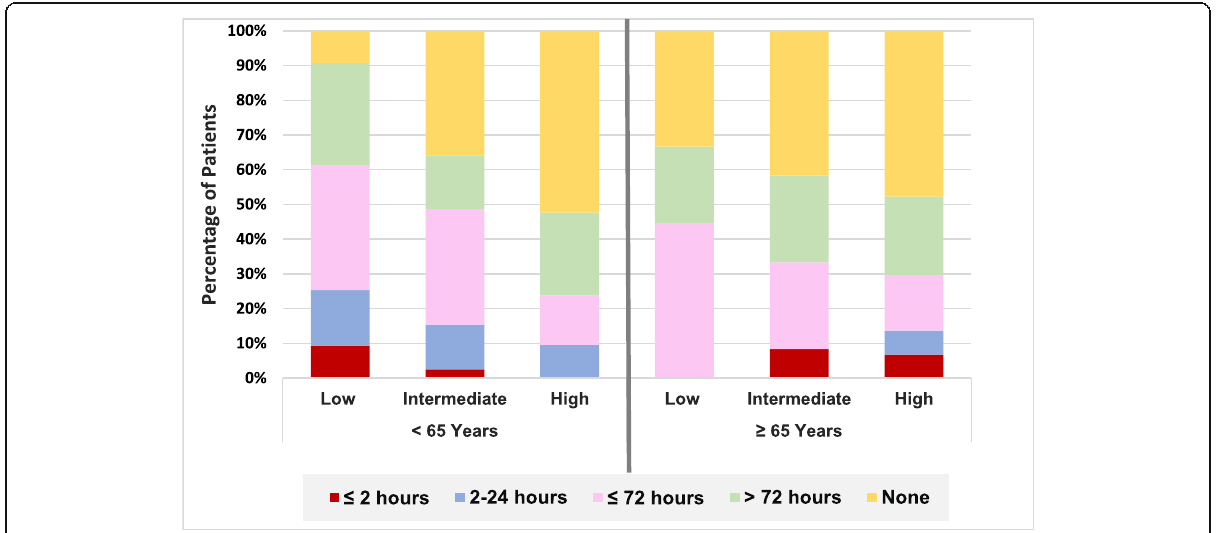
Fig. 2 Timing to catheterization in NSTE-ACS according to age and GRACE risk class. Comparing timing to catheterization between the two age